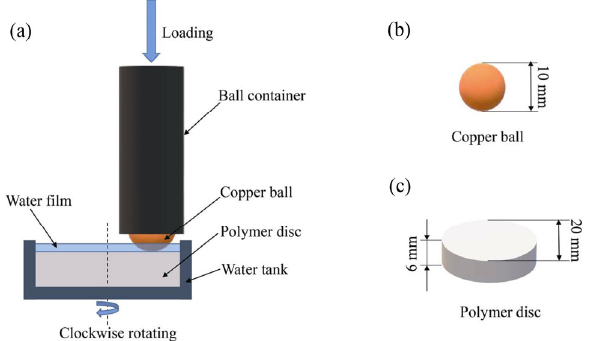
Fig. 1 Schematic illustration of the friction test and the friction pairs: (a) test configuration, (b) copper ball, and (c) polymer